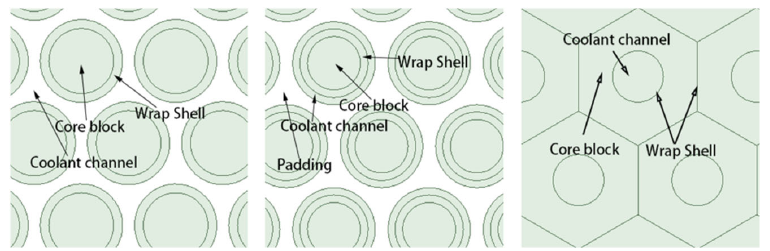
Figure 15. Three models for the numerical simulation of Yu [9].